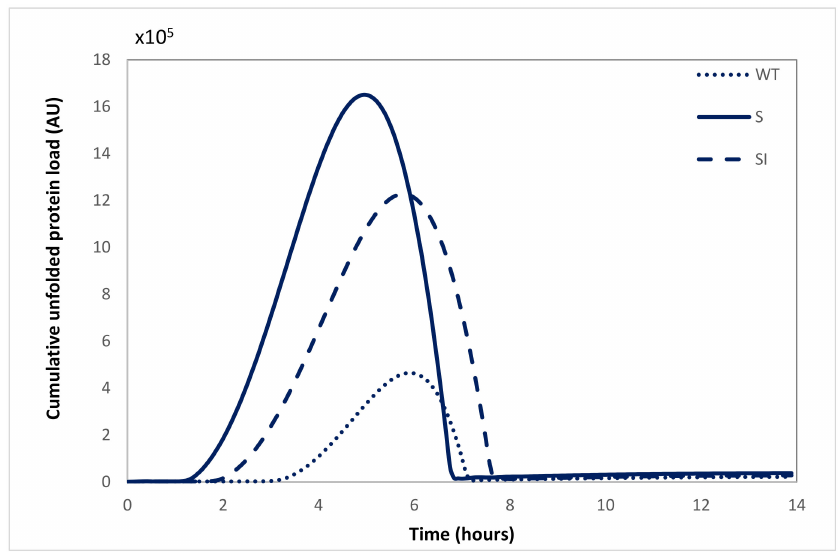
Figure 5. Model-generated profile of the unfolded protein load in each cell line with respect to time post-Tm